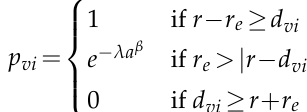
(c) Neyman-Pearson detector